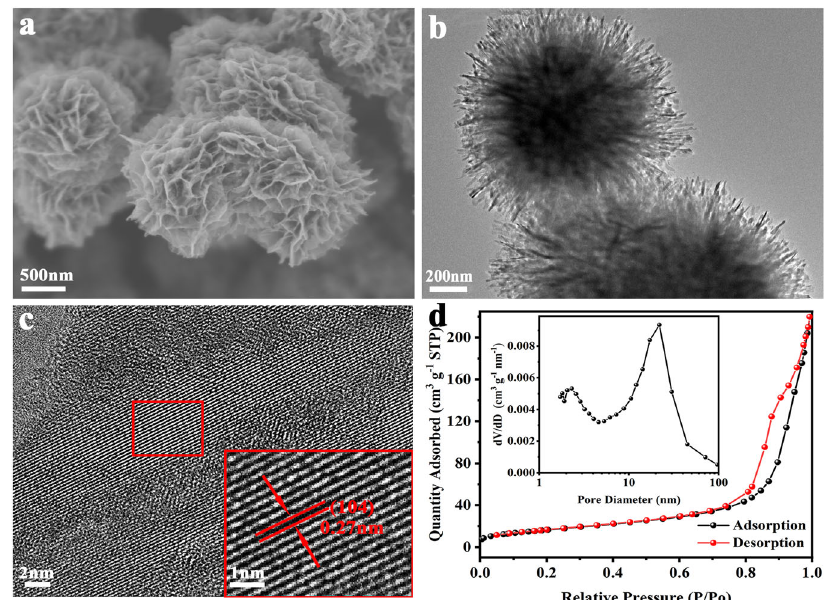
Fig. 1 Physicochemical characterization of V d – V 2 O 3 . a SEM image. b TEM image. c HRTEM image. d Nitrogen adsorption and desorption isotherms. inset: pore size distribution.